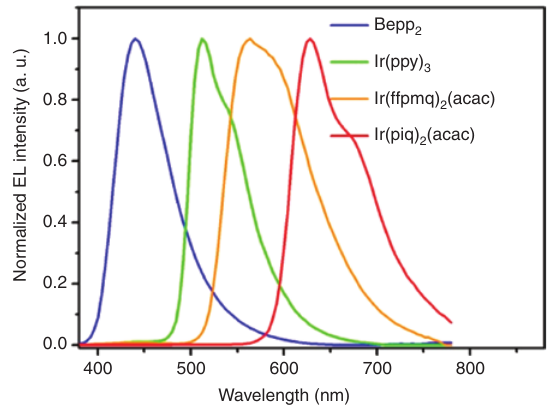
Figure 2: Normalized monochromatic EL spectra of four emitters